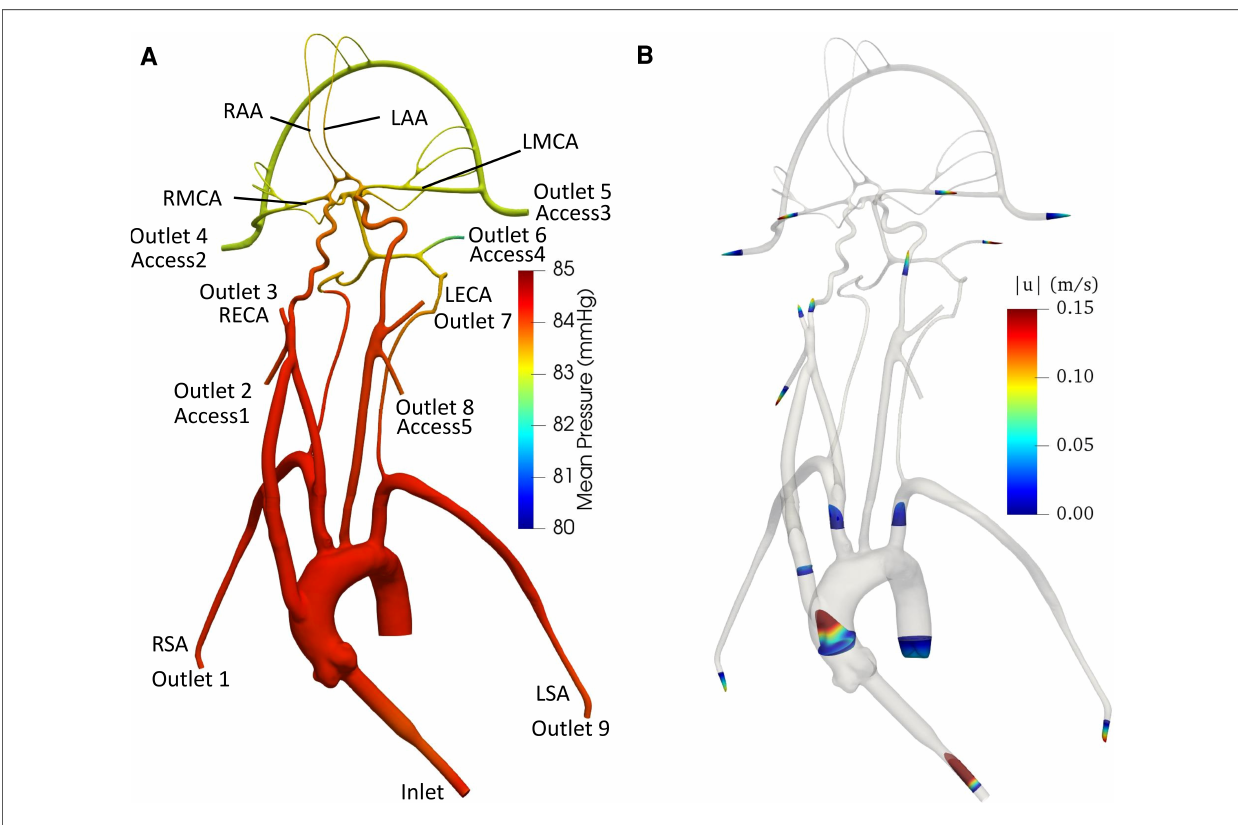
FIGURE 6 ( A ) Mean pressure contours and ( B ) pro fi les of mean velocity at various sections in the anatomical cerebrovascular model from CFD for the normal